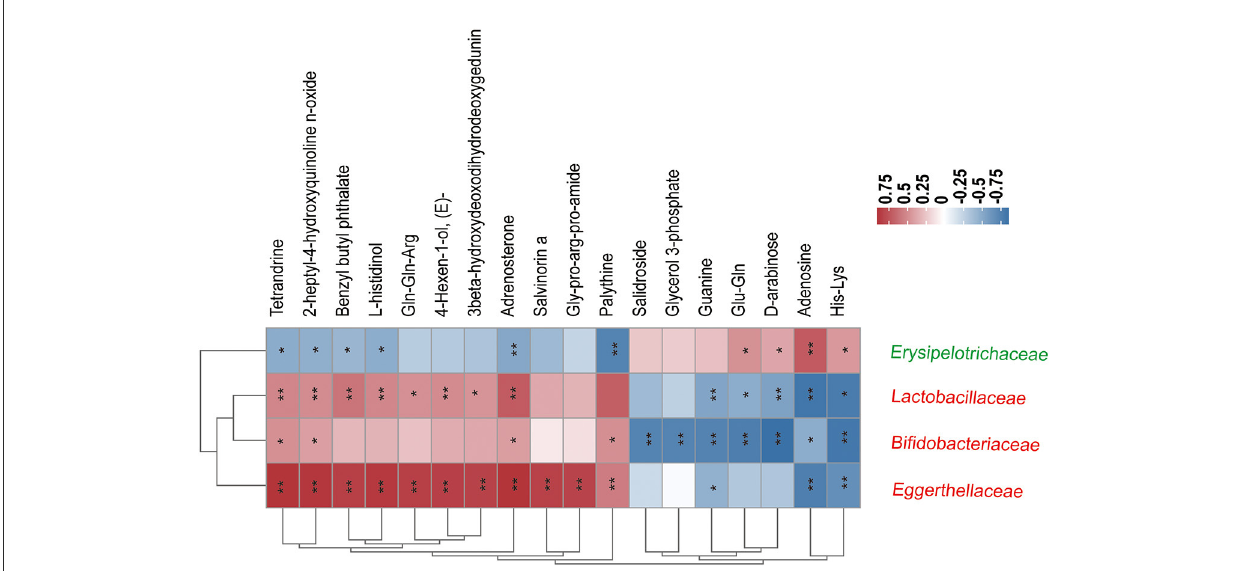
FIGURE8 Correlation coefficients between the relative abundance of four ME-associated bacterial families and the top 20 fecal metabolites in the treated groups. The color depth of the grids depicted the strength of the correlation (red square = positive correlation, blue square = negative correlation. * p < 0.05, ** p < 0.01). Increased and decreased relative abundance in AOM/DSS mice treated by ME were denoted by red and green tags,